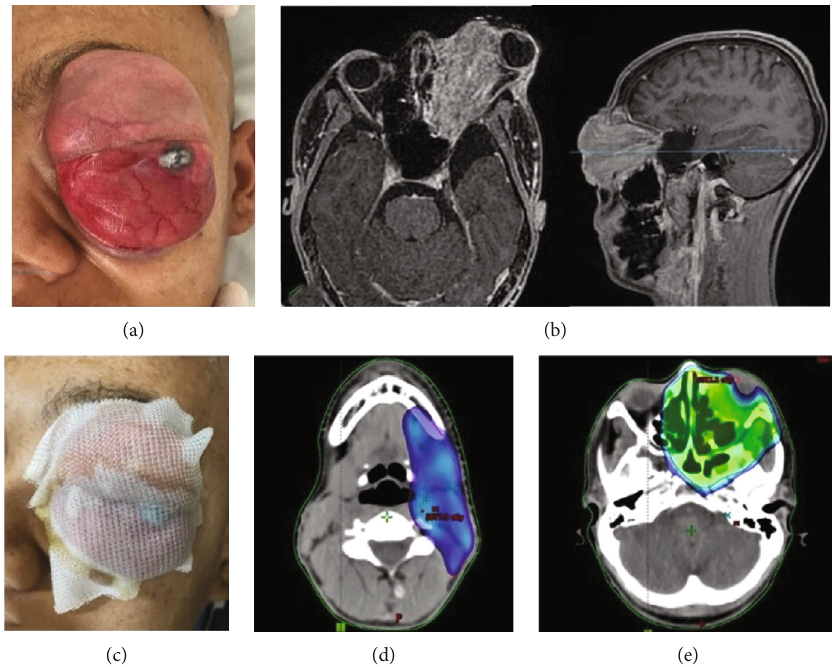
Figure 3: Clinical examination after neoadjuvant QT. (a) Partial response to treatment was observed with increased tumor volume. (b) MRI in axial and sagittal slices con fi rmed. (c) CT for RT planning. (d) PTV contouring included submental lymph nodes. (e) CTV for tumor